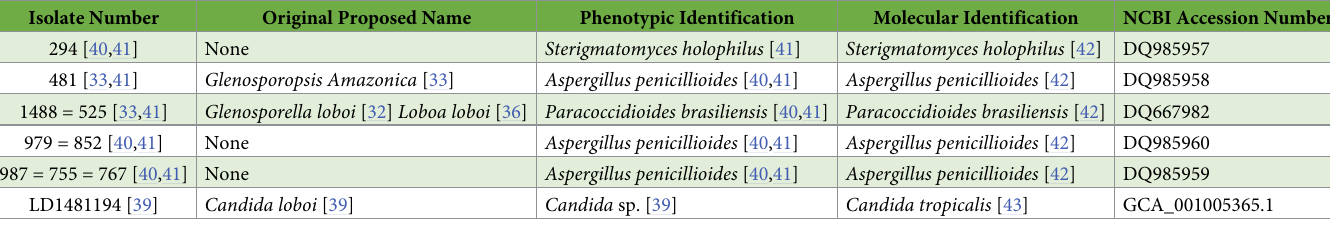
Table 3. Molecular study of Jorge Loˆbo’s disease contaminants suggested as the disease etiology.